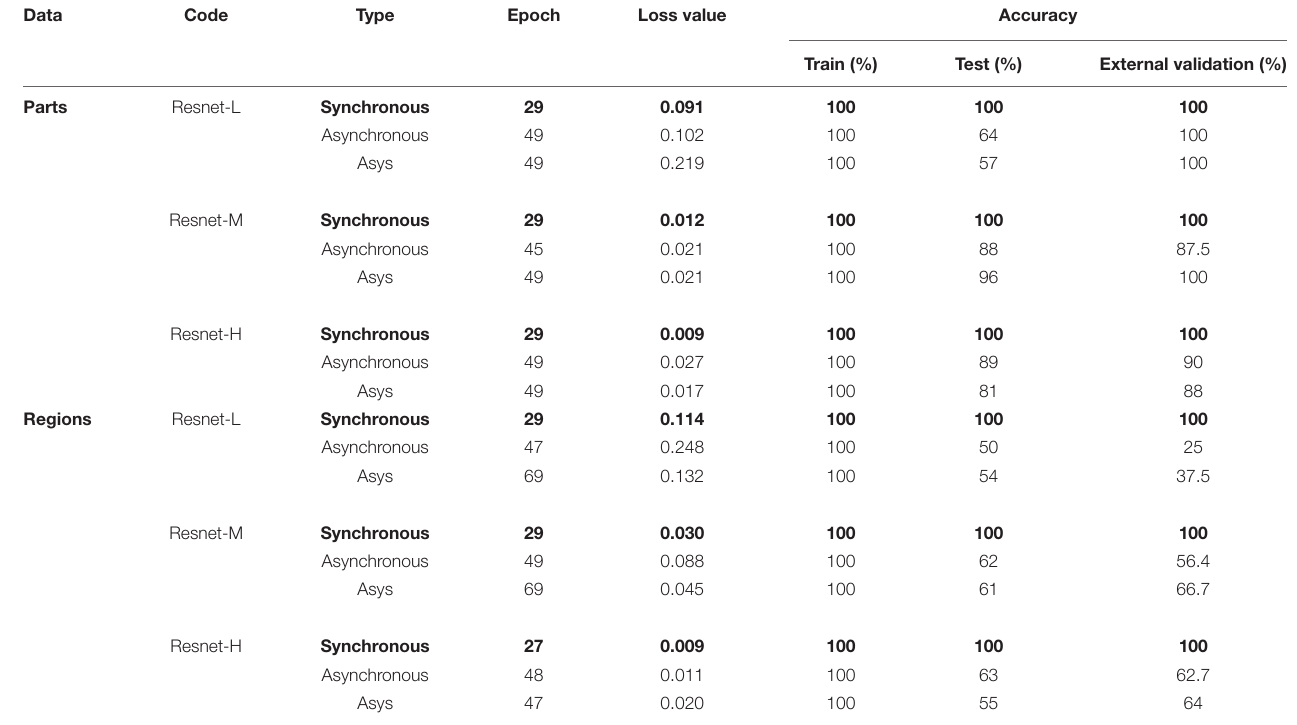
TABLE 3 | The accuracy of ResNet models for parts and regions identification based on three levels of data sets. Data